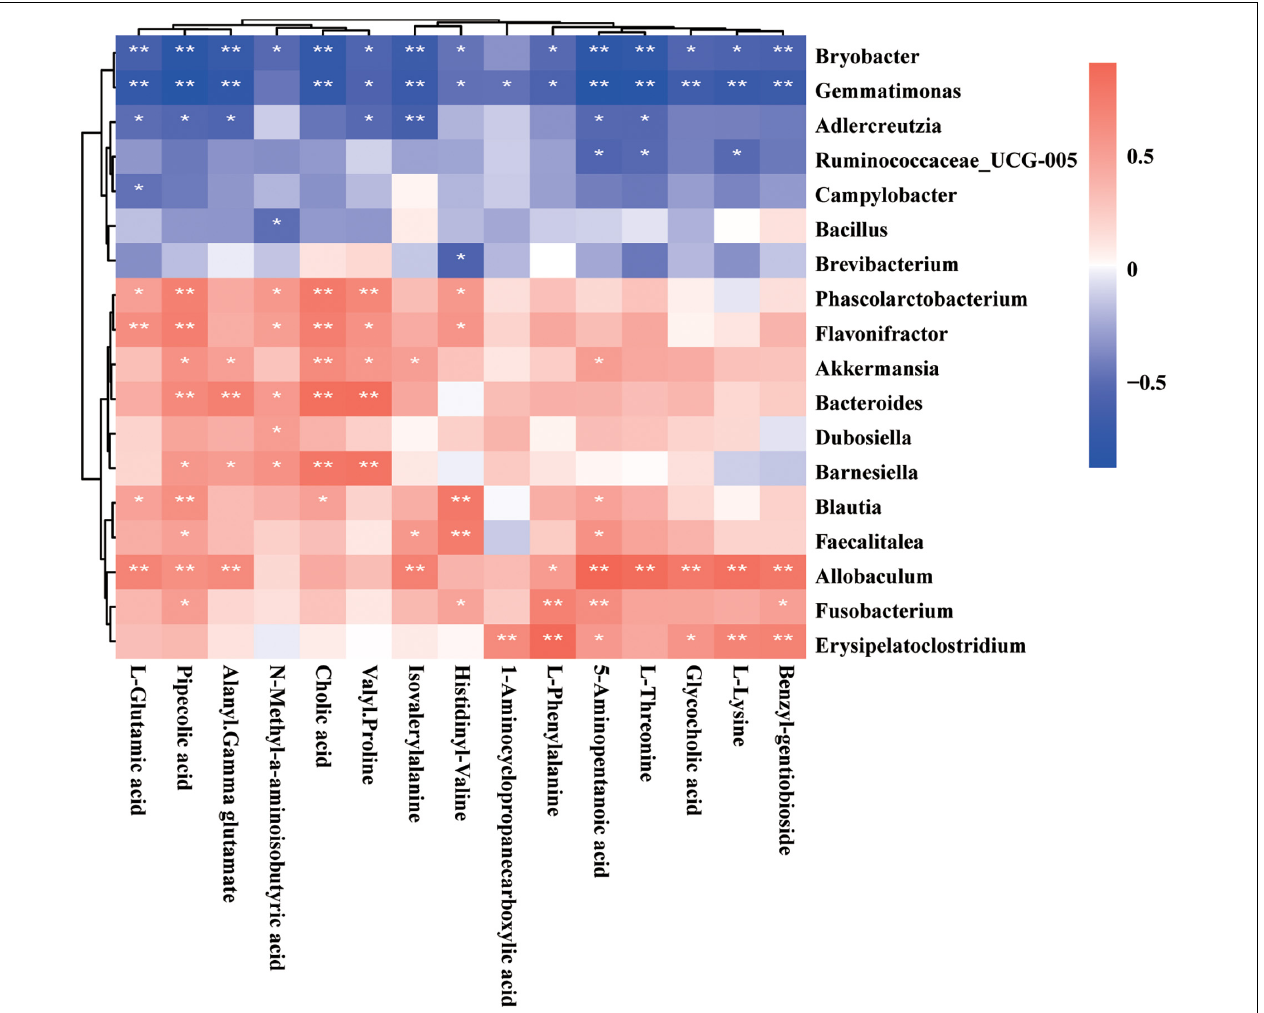
FIGURE 7 | Spearman’s correlation analysis of metabolites and gut microbiota. The r -values were denoted with graduated colors, and red and blue grids indicated positive and negative correlations, respectively (* P < 0.05 and ** P < 0.01).